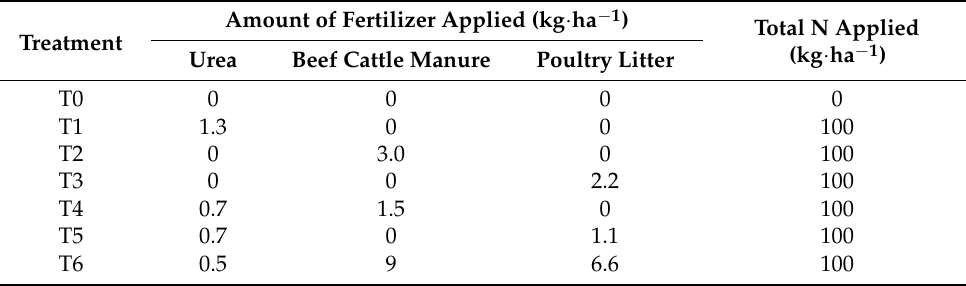
Table 3. Amounts of natural and synthetic organic N-fertilizers applied in each treatment.